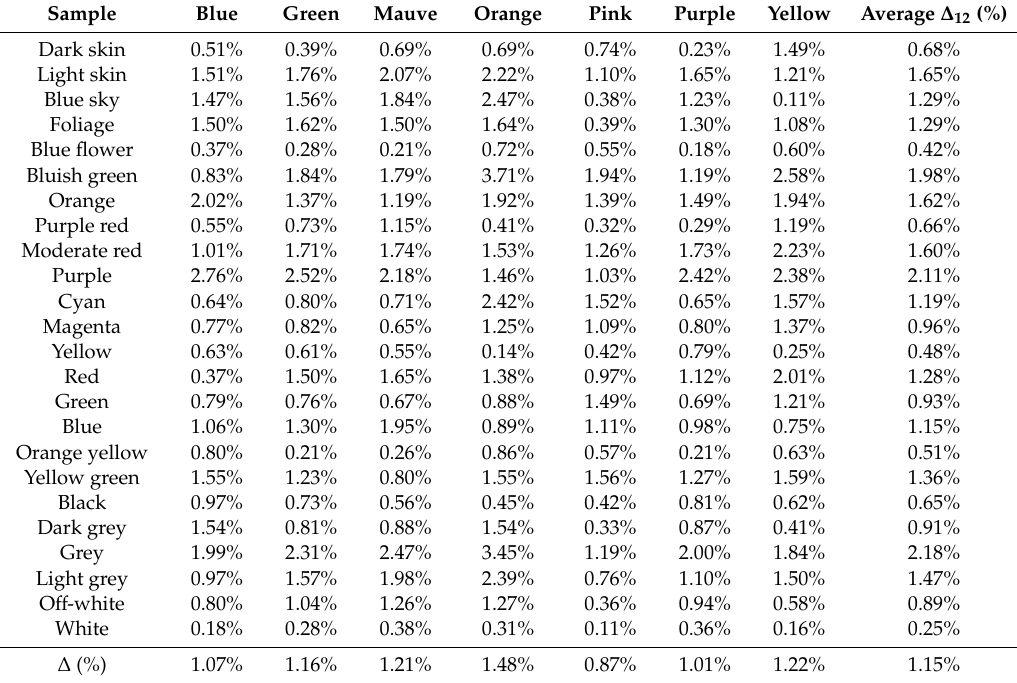
Table A3. Values of ∆ 12 for each colour square of the colour plate and values of ∆ for the di ff erent images of the coloured paper, displayed in Figure A10. The average global variation is only 1.15%.